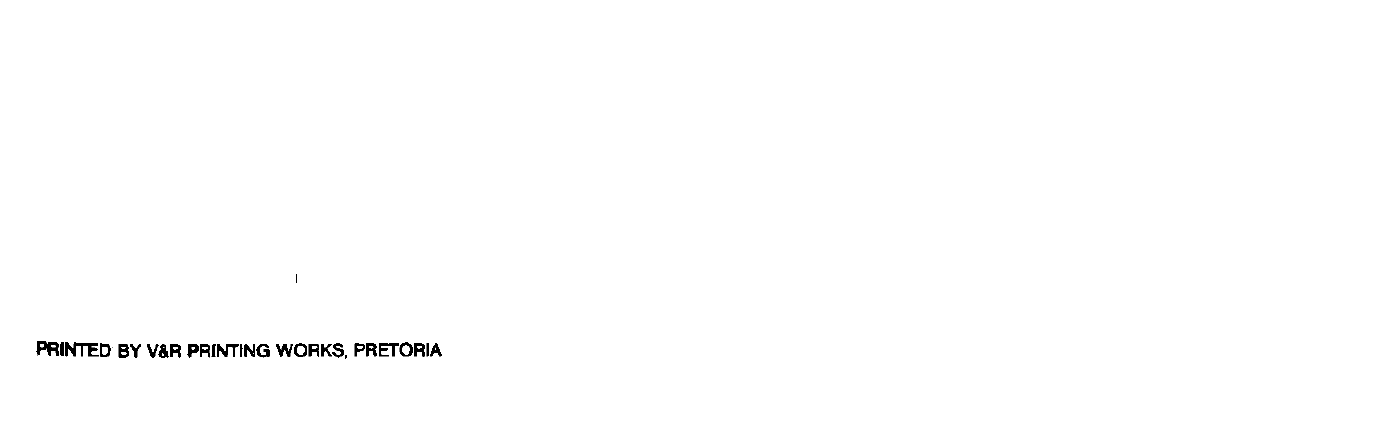
TABELLE EN FIGURE wat op afsonderlike bladsye (een bladsy per tabel/illustrasie) moet verskynj moet vir referent doeleindes